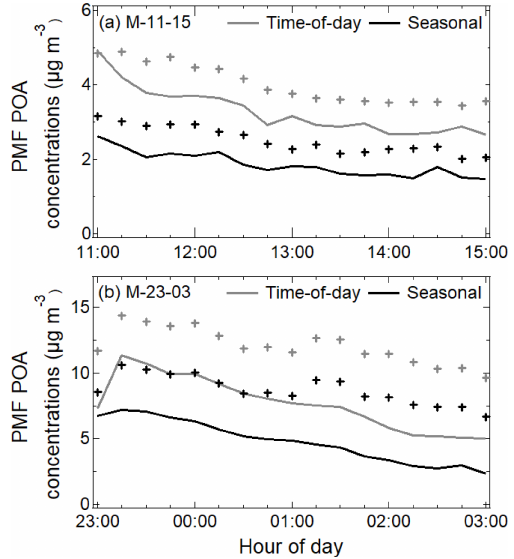
Figure 6. The 15min averaged seasonally representative diurnal mean ( + ) and median (lines) concentration time series of POA for the periods (a) M-11-15 and (b) M-23-03 (in µgm − 3 ) . Nighttime factors show stronger evidence of episodes.